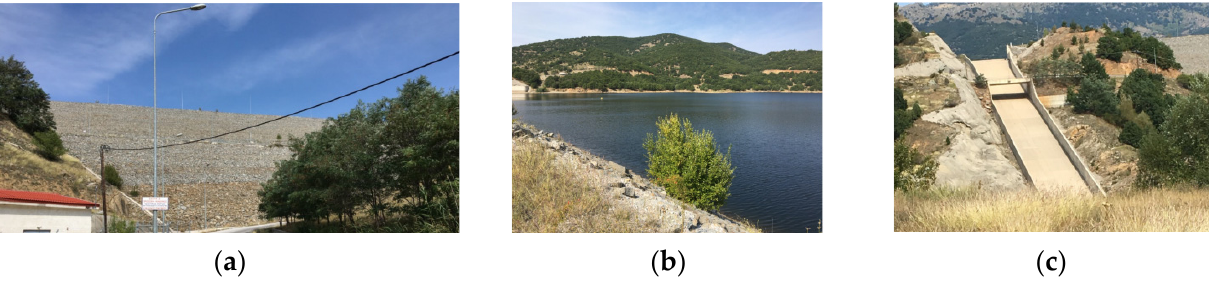
Figure 3. View of the Papadia dam. ( a ) View of the dam from downstream. ( b ) View of the reservoir from the dam crest. ( c ) View of the spillway from downstream.